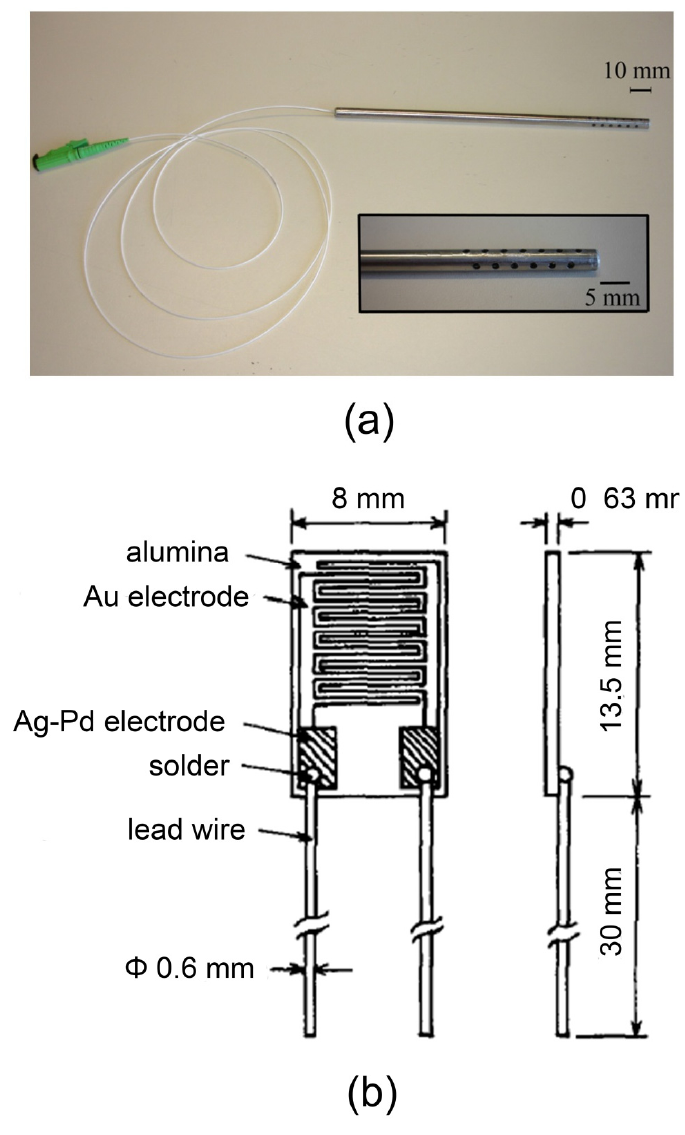
Figure 1. ( a ): Prototype of the improved RH optical sensor equipped with a protective stainless